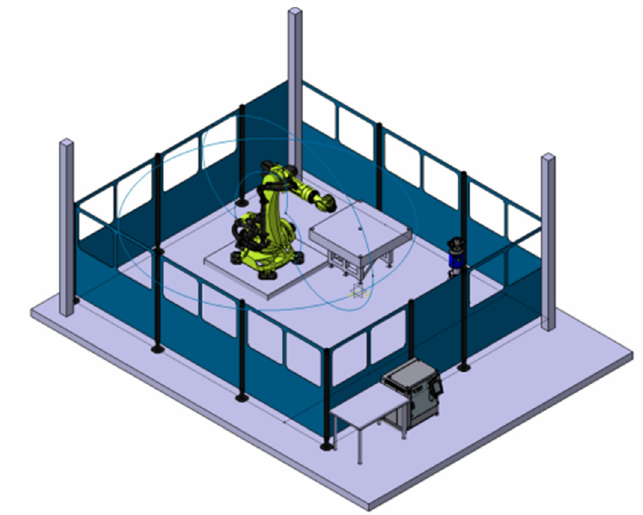
Figure 1. Laboratory for Integrated Metrology Applications (LIMA) robotic cell.